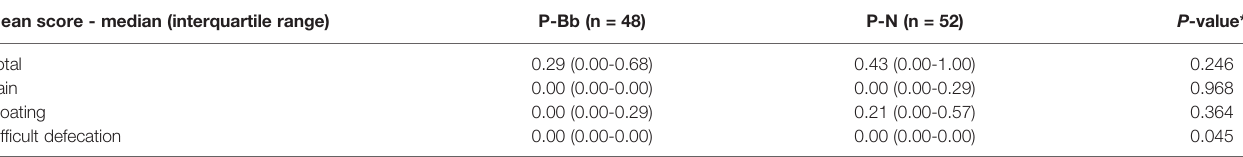
TABLE 2 | Postoperative symptoms.